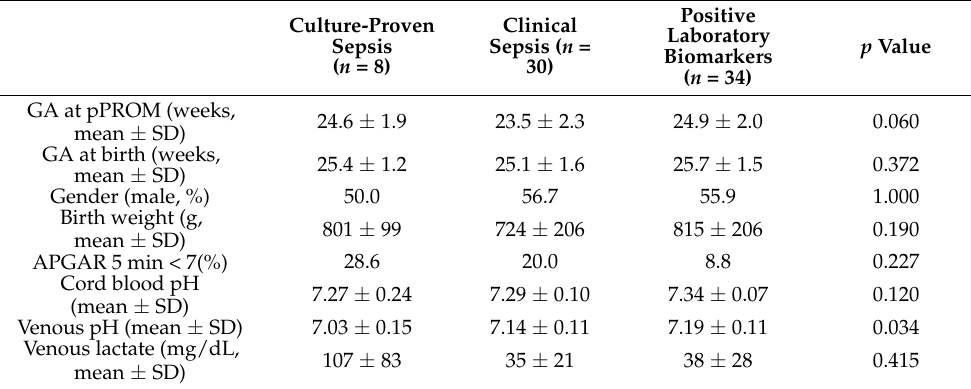
Table 2. Patient characteristics of the three groups of infants with sepsis ( n =